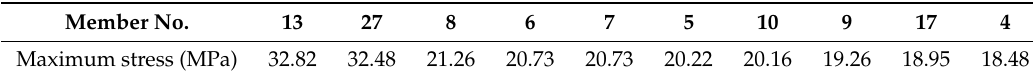
Figure 4. Stress history of Members 13 and 27. 3.3. Random Variables and Deterministic Parameters In this research, the statistical information of random variables is determined through a comprehensive literature review [10,15,19,36–38], and the mean, coefficient of variation (c.o.v.), and distribution type of the random variables in this numerical example are summarized in Table 2. Table 2. Statistical properties of random variables. Random Variable (RV)